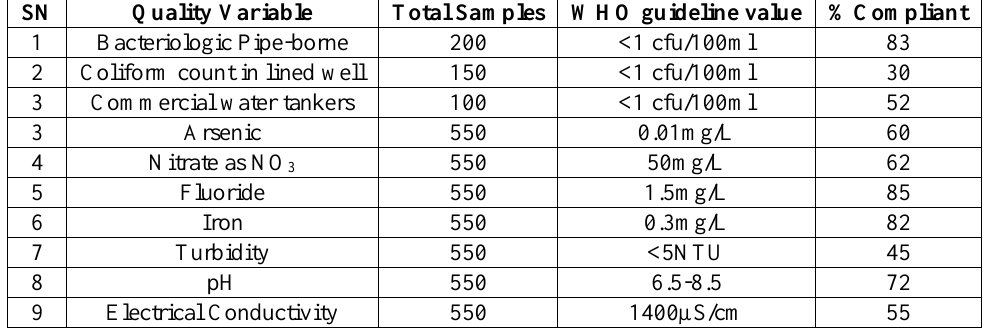
Table 4: Compliant of some Water quality sampling data for the study